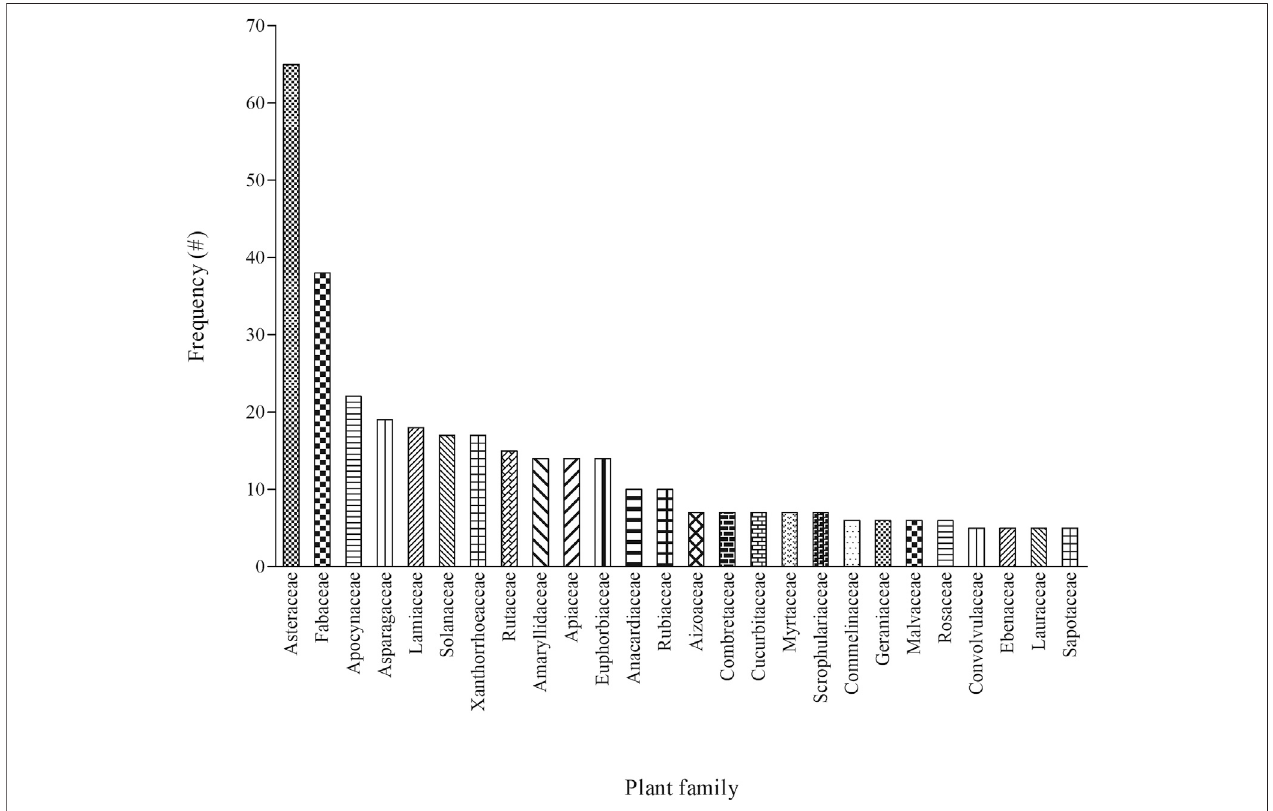
FIGURE3| Distributionoffamilieswith fi veormoreplants(n ≥ 5)indicatedasaremedyforpainandin fl ammatory-relatedconditionsamongdifferentethnicgroups in South Africa, # (cid:1) number of